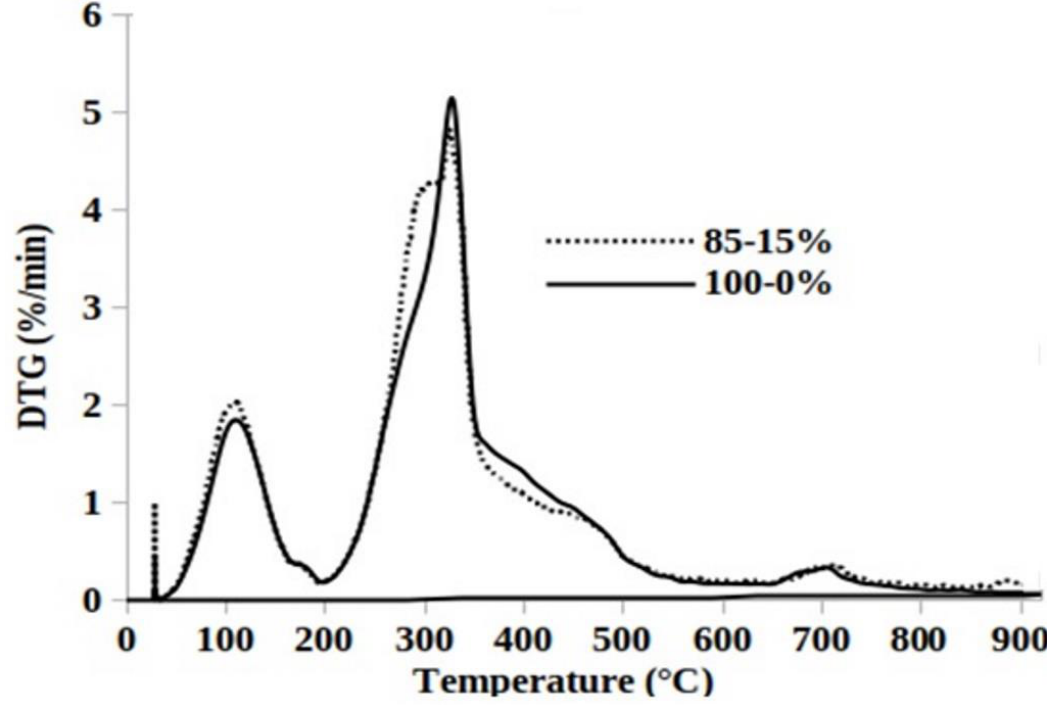
Figure 5. DTG evolution as a function of the temperature.